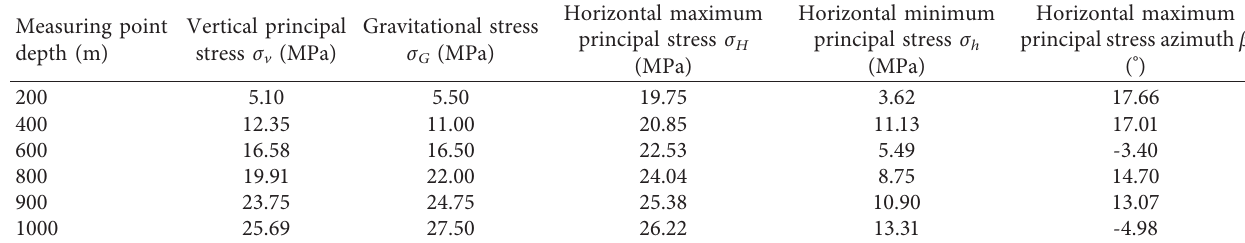
Table 2: Magnitude and direction of principal